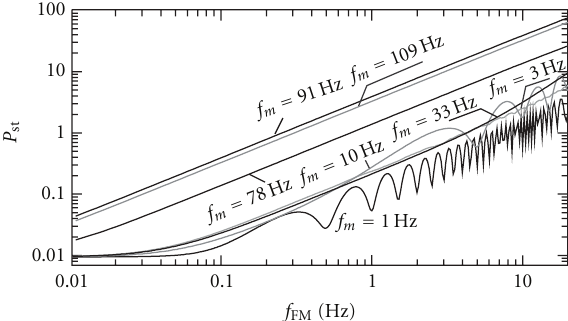
Figure 13: P st = f ( Δ f FM , f m ) characteristics for rectangular modulating signals for a changing values of f m